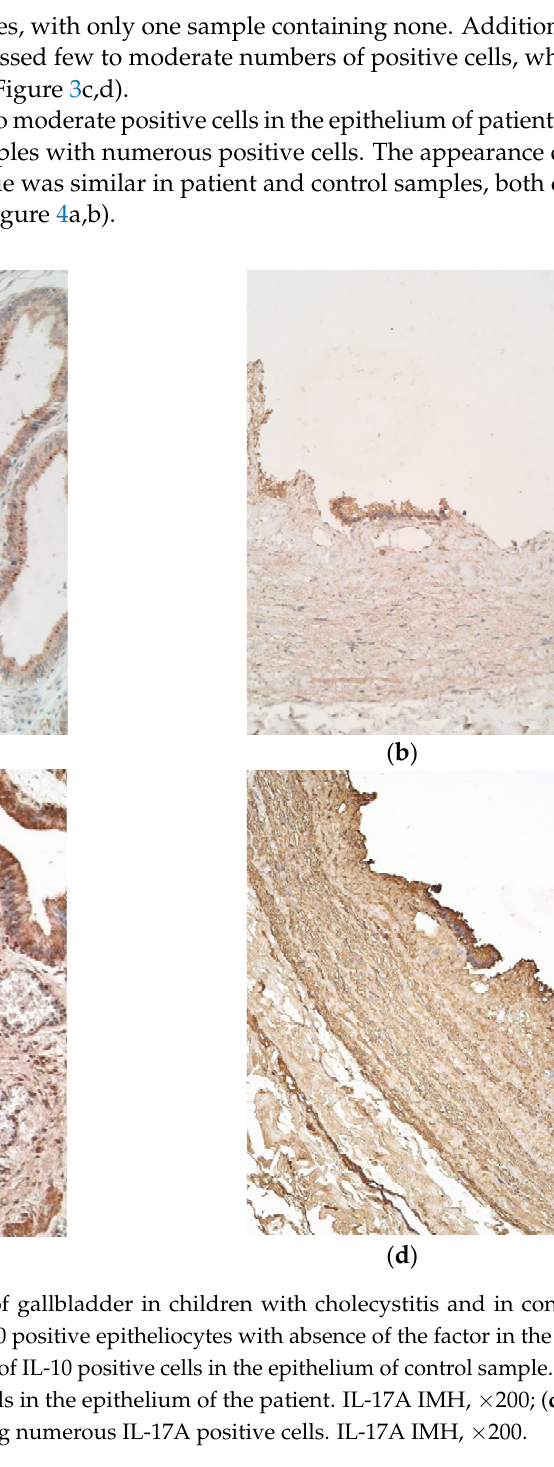
Table 3. Significant differences in interleukins of epithelium and connective tissue between patient and control tissue samples.